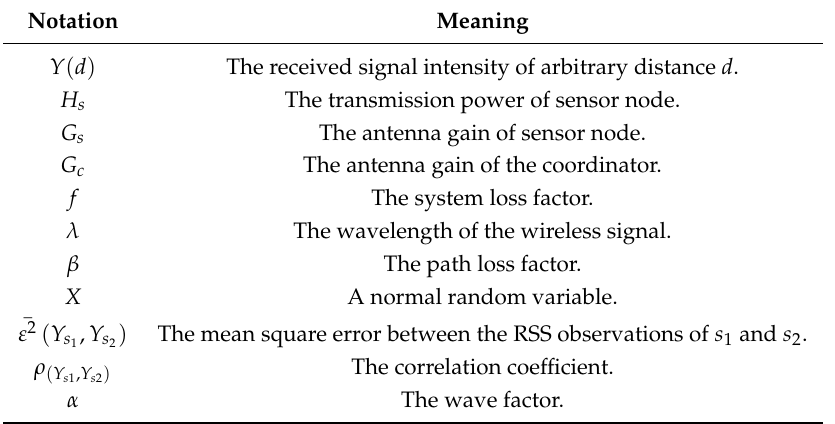
Table 1. The meaning of